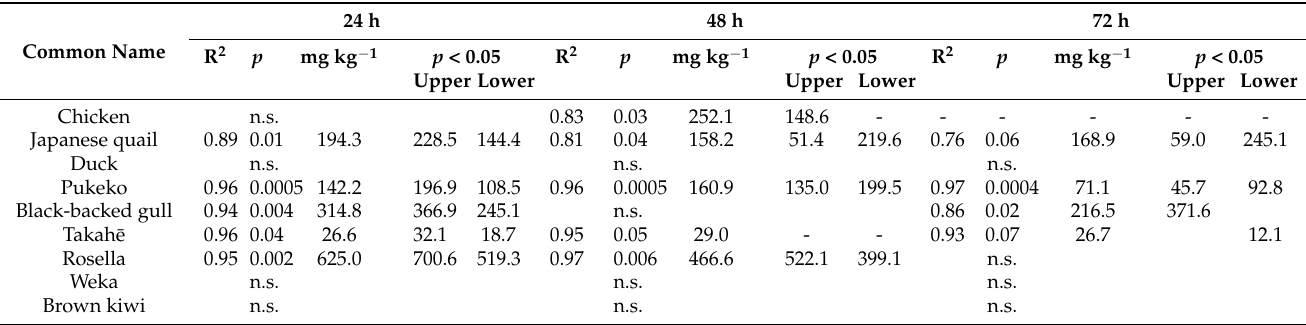
Table 4. Goodness of fit (R 2 ) and significance ( p ) for model of PAPP doses (mg kg − 1 ) given at T0 when projected to exceed 2 SDs of the mean T0 value for the methaemoglobinaemia absorbance index (1/MAI) at 24, 48 and 72 h with upper and lower confidence ( p < 0.05). Null results denote that no shifts beyond 2 SDs were detected.